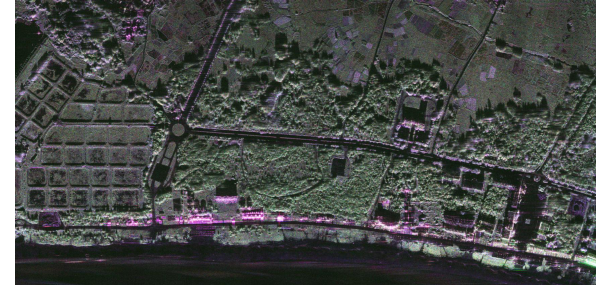
Figure 6 1:2000 3D mapping products of experimental area of 1:2000 mapping specification.